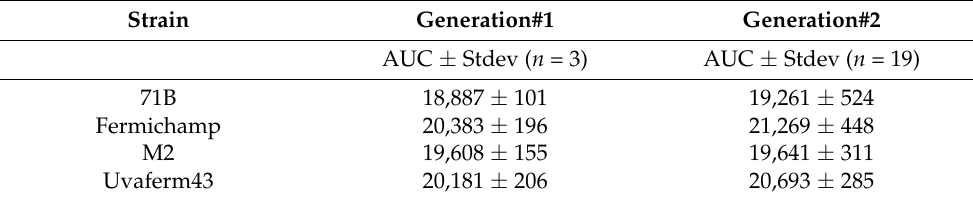
Table 1. Comparison of fermentation performance of four wine yeast fermented in CDGJM (230 g L − 1